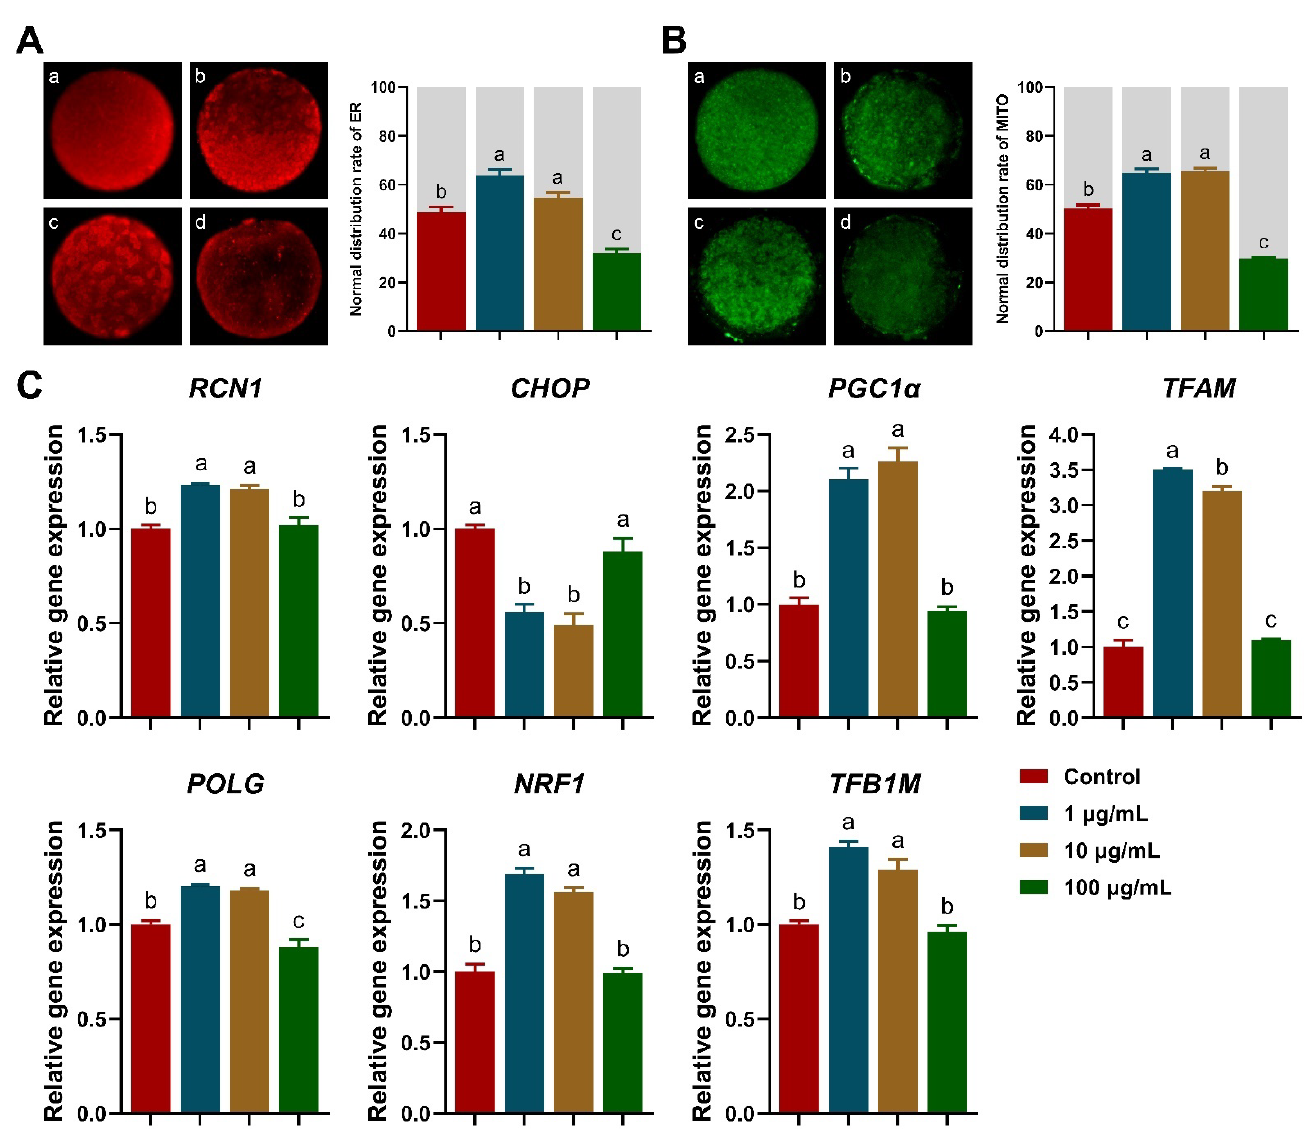
Figure 3. Effects of TA on the distribution of endoplasmic reticulum (ER) and mitochondria in porcine oocytes. ( A ) ER distribution: ( a ) homogeneous distribution (normal); ( b – d ) unequal distribution (abnormal). ( B ) Mitochondria distribution: ( a ) peripheral (normal); ( b – d ) cortical or diffused (abnormal). ( C ) ER and mitochondrial biogenesis-related gene expression. Within the same indicator, bars with different letters are significantly different ( p < 0.05). Results are shown as the average ± SEM of at least three repeats of independent experiments. A total of 30 oocytes were analyzed per group in each replicate.